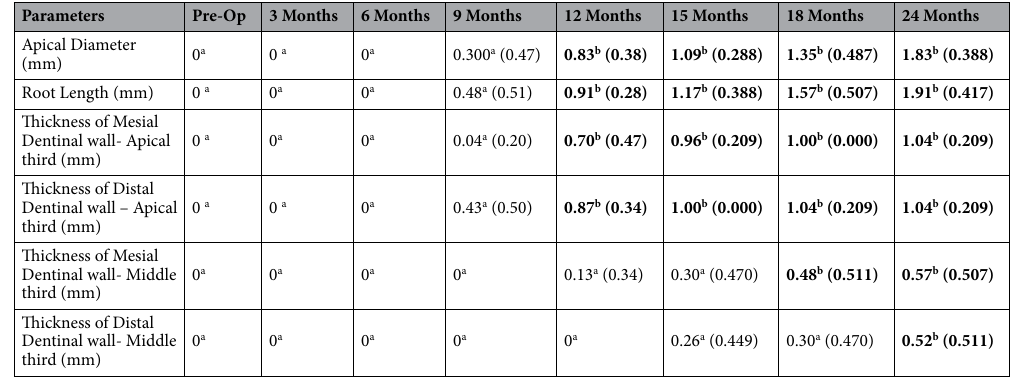
Table 1. Mean (Standard deviation) of difference between Pre- and Post-operative values of various parameters. a,b Different alphabetical superscript for each time period indicates the statistical significant difference ( p <